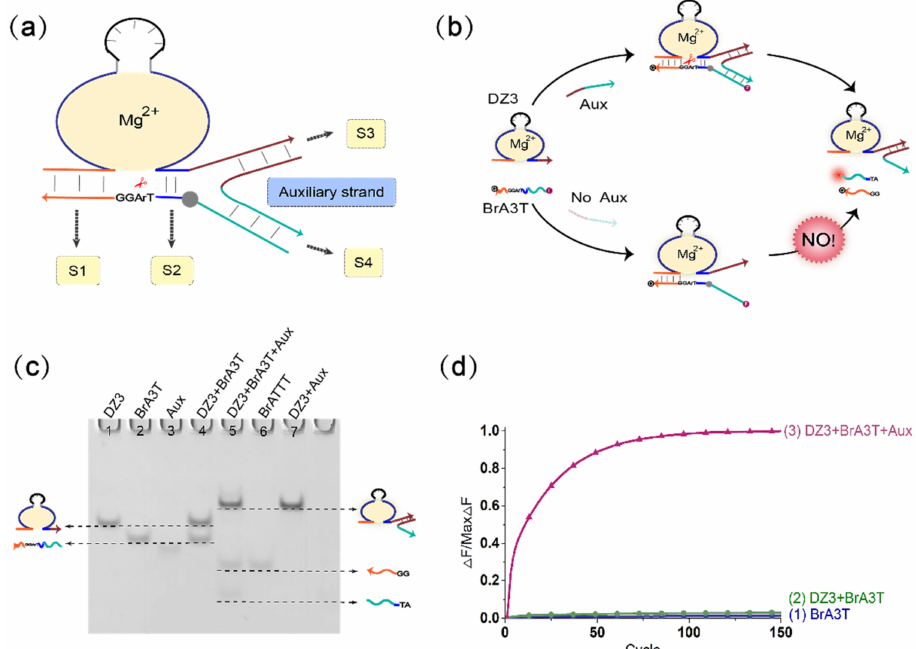
Figure 1. ( a ) Diagram of the mechanism of the DNAzyme binding to a single auxiliary strand to cleave the substrate. The mechanism is composed of the DNAzyme, an auxiliary strand, and a substrate strand. The three strands combine to form a three-pronged complex structure. The stems S1, S2, S3, and S4 are the important parts of the three-pronged complex structure. ( b ) The detailed process demonstration diagram of the mechanism of the DNAzyme binding to a single auxiliary strand to cleave the substrate. The 5 (cid:48) end of the substrate strand is labeled with FAM fluorophore, and the 3 (cid:48) end is labeled with the quencher BHQ1 for the fluorescence signal measurement. ( c ) PAGE analysis of the mechanism of the DNAzyme binding to a single auxiliary strand to cleave the substrate. The strands and complexes involved are marked above the lane number. Lane 1, DNAzyme DZ3; lane 2, substrate strand BrA3T; lane 3, input strand Aux; lane 4, DNAzyme DZ3 and substrate strand BrA3T reaction; lane 5, combination of the input strand Aux with the mixture of DNAzyme DZ3 and substrate strand BrA3T; lane 6, product strand BrATTT; lane 7, complex of DNAzyme DZ3 and auxiliary strand Aux. ([DZ3]:[BrA3T]:[Aux] = 1:1:1, [DZ3] = [BrA3T] = [Aux] = 0.6 µ M). ( d ) the normalized fluorescence map of the mechanism of the DNAzyme binding to a single auxiliary strand to cleave the substrate. Curve (1), only the fluorescent substrate strand is present; curve (2), no input strand Aux is added, and only the DNAzyme DZ3 and fluorescent substrate strand BrA3T are added; curve (3), add the input strand Aux to the mixture of DNAzyme DZ3 and substrate strand BrA3T. ([DZ3]:[BrA3T]:[Aux] = 1:1:1, [DZ3] = [BrA3T] = [Aux] = 0.3 µ M). The sampling interval is 4 min, 150